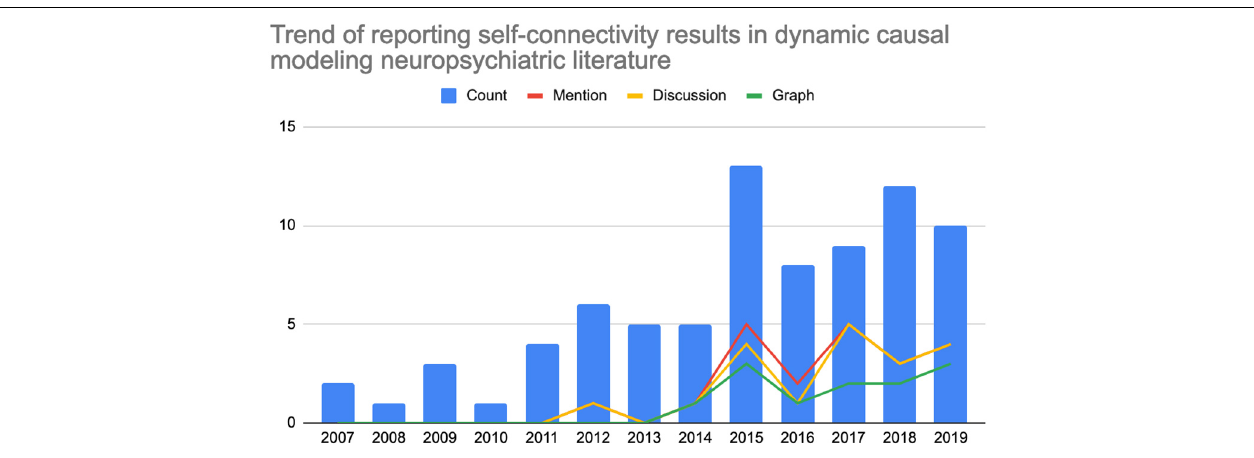
FIGURE 1 | Count of references (left axis) by year within the literature review which (0, blue) total number of neuropsychiatric references reporting dynamic causal modeling findings per year; (1, red) count of references making any mention of self-connectivity results; (2, yellow) count of references including self-connectivity with the discussion; or (3, green) count of references demonstrating self-connectivity findings in graphical